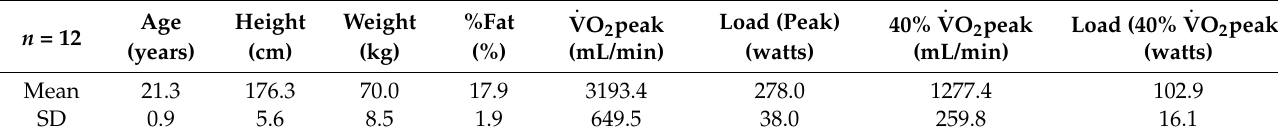
Table 1. Characteristics of the participants included in the